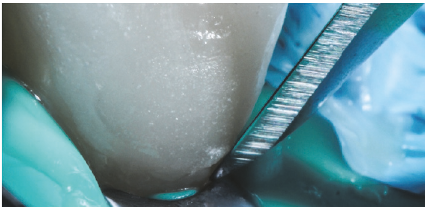
Figure 17: Excess cement removal with a brush. The cement used was value +2 from Variolink Veneer system (Ivoclar Vivadent, Liechtenstein, Germany).